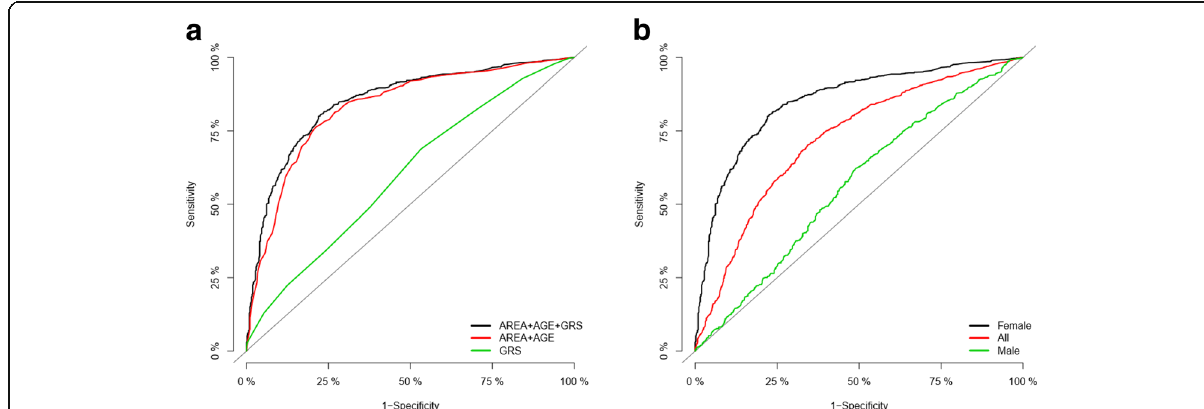
Fig. 4 Receiver operating characteristic (ROC) curves for models to predict MetS in the discovery stage (KARE study). ( a ) In KARE females, AUC measured from the ROC curve of a model comprising area, age, and female-specific GRS as predictor variables showed higher value (black) compared to those of other models adjusted with area and age (red) or with only female-GRS (green). ( b ) In a model comprising area, age, and female-GRS, AUC showed higher value in females (black) than in males (green) or all subjects